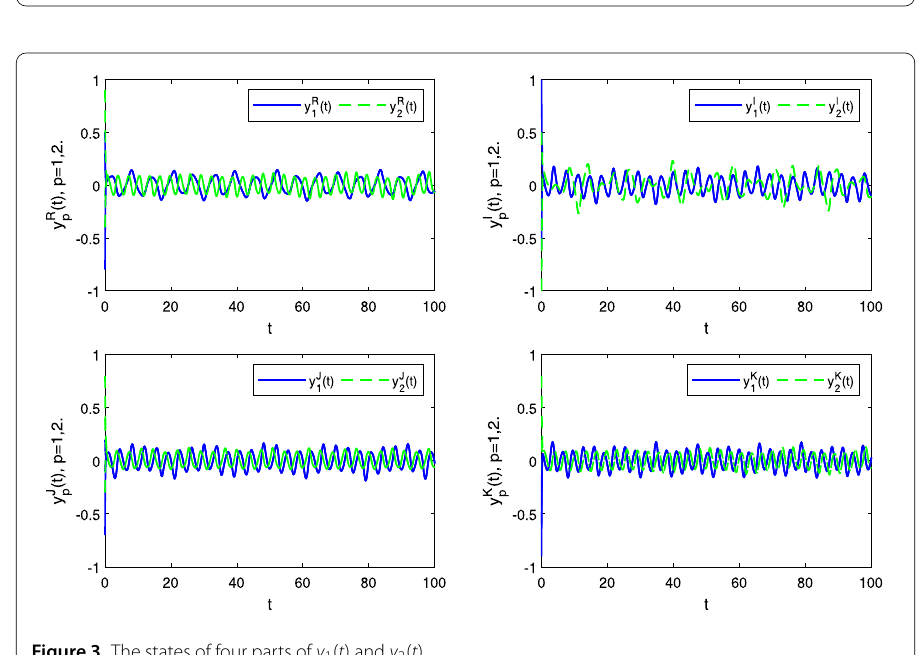
Figure 2 The states of four parts of x 1 ( t ) and x 2 ( t )